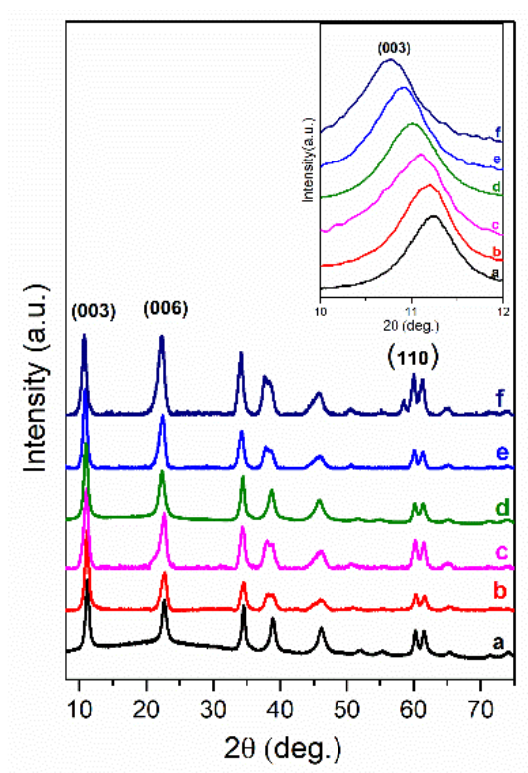
Figure 2. XRD patterns of Mg 3 /Al-CO 3 LDH ( a ) and Mg 3 /Al-CO 3 intercalated with organic anions Mg 3 /Al-4-dimethylaminobenzoate ( b ), Mg 3 /Al-4-methylbenzoate ( c ), Mg 3 /Al-1,3,5-benzentricarboxylate ( d ), Mg 3 /Al-benzoate ( e ) and Mg 3 /Al-4-biphenylacetonate ( f